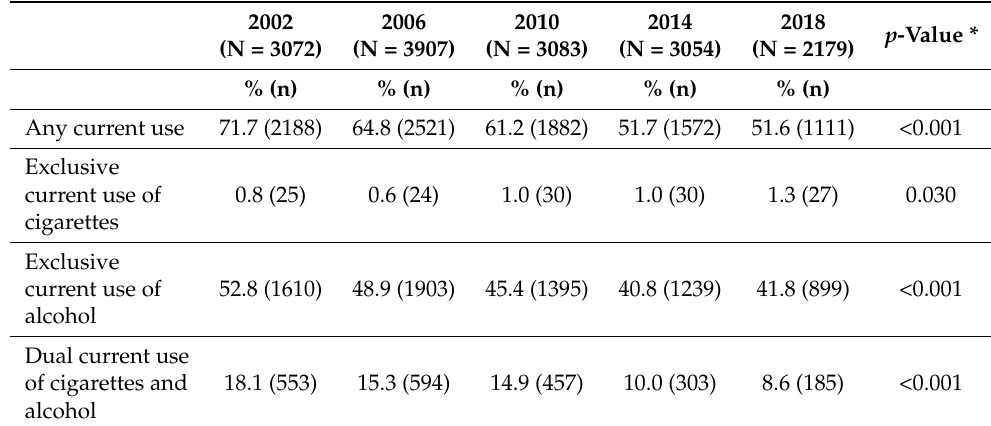
Table 2. Overall smoking and alcohol patterns at five time points, 2002–2018.